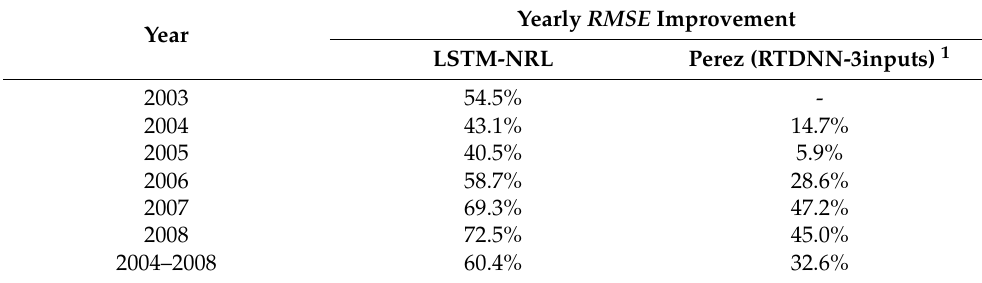
Table 8. The RMSE improvement comparison between LSTM-NRL and RTDNN-3inputs in 6